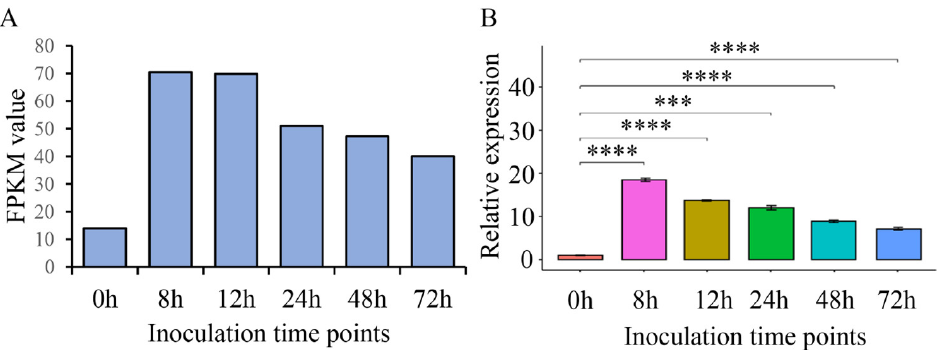
Figure 4. Expression of ThSCSP_14 during T. horrida infection of the kernel smut–susceptible rice cultivar 9311A. ( A ) Transcriptome data. ( B ) The qRT-PCR analysis of ThSCSP_14. Rice kernels inoculated against T. horrida were collected at 0, 8, 12, 24, 48, and 72 h post-inoculation for gene expression analyses using the quantitative real-time reverse transcription polymerase chain reaction. UBQ expression served as an internal reference for normalizing expression levels within the samples. Error bars are the standard deviation (SD) of four independent replicates (*** p < 0.001, **** p < 0.0001).